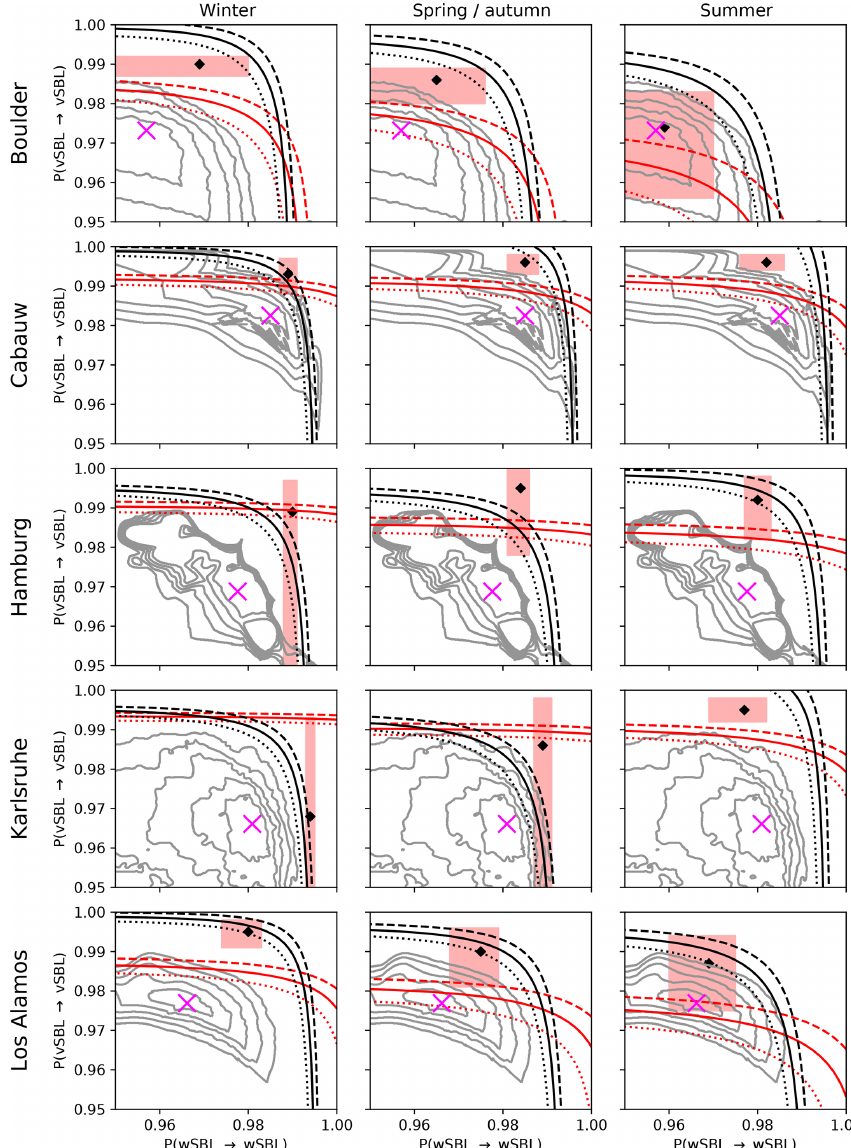
Figure 6. Values of persistence probabilities for which the occurrence probability of at least one wSBL to vBSL transition in a night (red lines) or one vSBL to wSBL transition in a night (black lines) as computed from a stationary Markov chain equals the observed values. Solid, dashed, and dotted lines correspond to, respectively, the observed values, a probability of 5% below the observed values, and a probability of 5% above the observed values. The ranges of persistence probabilities where the occurrence probability of very persistent nights in a stationary Markov chain agrees with observations in a ± 5% uncertainty band is depicted by the red rectangle with a diamond displaying the values from VP ref . The persistence probability values corresponding to 95% to 99% total consistency of the perturbed VP with VP ref in the HMM analysis are depicted in grey contours. The persistence probabilities corresponding to Q ref values are marked by a pink